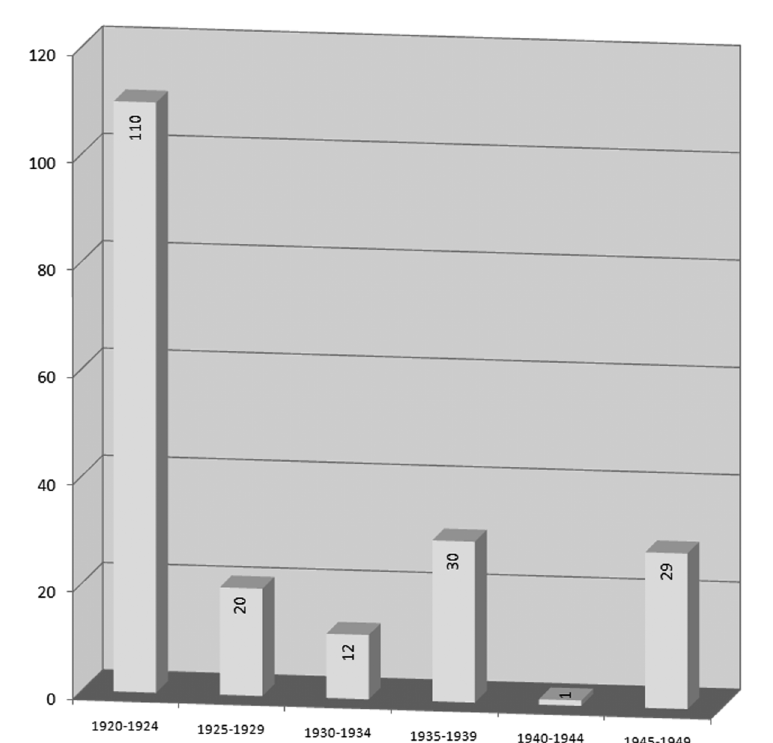
Fig. 4. Number of letters for five-years period of the Alberoni Observatory epistolary from 1920 to 1950. After this period few letters